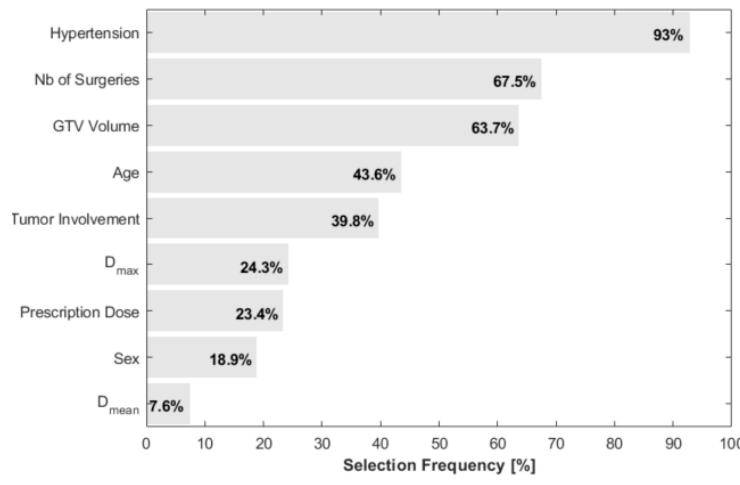
Figure 1. LASSO-based parameter selection frequency over 1000 bootstrap samples.